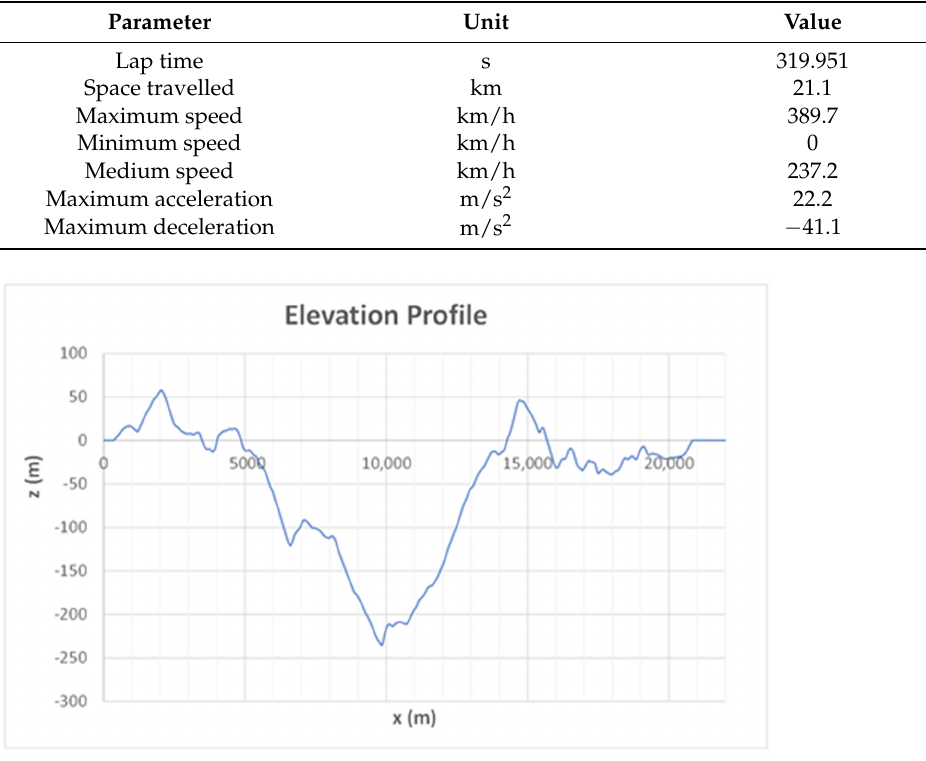
Figure 15. Nürburgring track, in its Nordschleife variant. Table 6. The table shows the main information of the hypercar driving cycle.